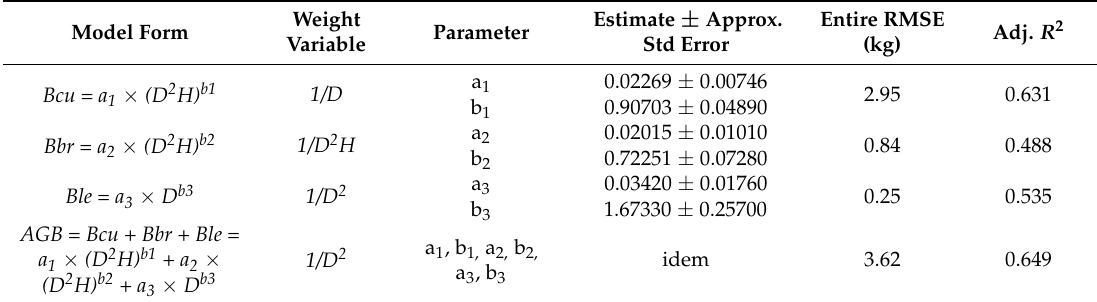
Table 4. SUR method estimating parameters of selected model combination of bamboo biomass components using the entire